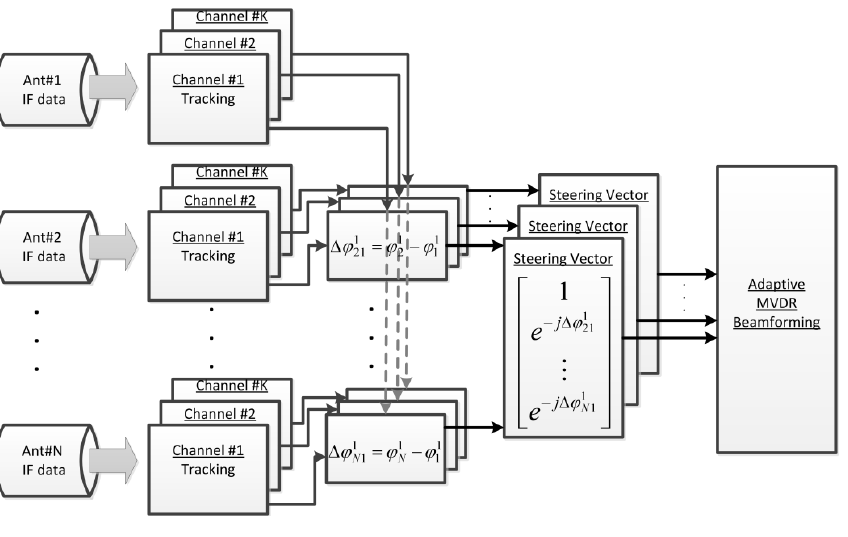
Figure 3. Mechanism to obtain the steering vectors in the software